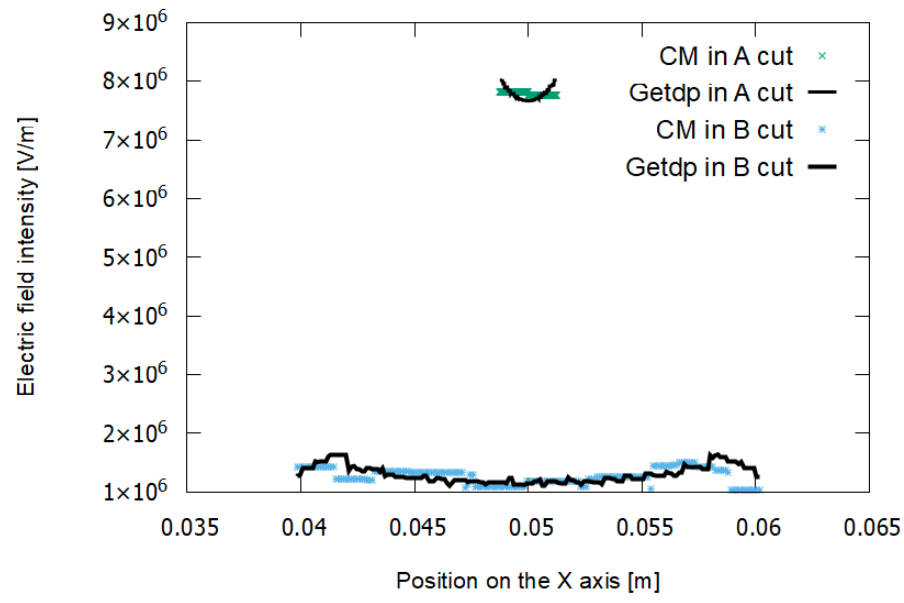
Figure 16. Electric field in cut A (upper curves) and cut B (lower curves) for experiment E2.